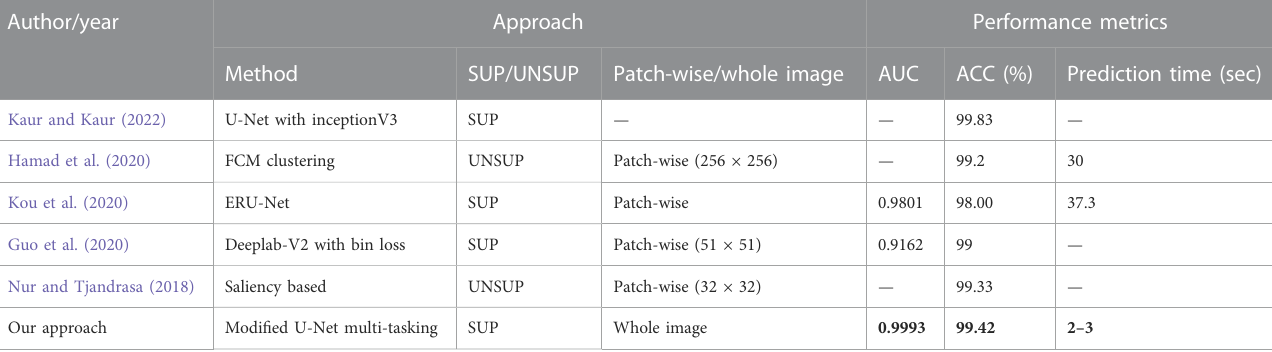
TABLE 3 Comparison of our method for segmentation of exudate images with other up-to-date approaches on the IDRiD dataset. As our predictions are for whole images, our prediction times are much faster (about 12 times) compared to other state-of-the-art techniques on the IDRiD dataset. Best results are shown in bold.